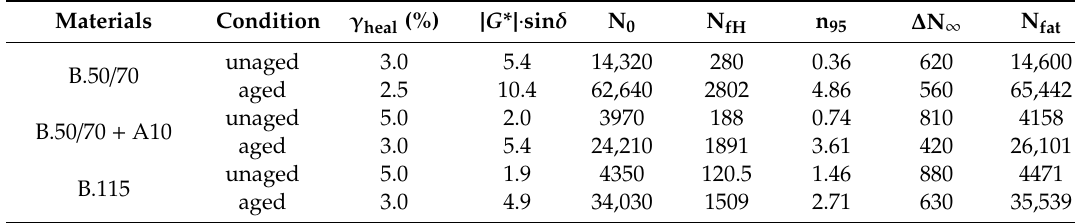
Table 6. Healing parameters in iso-thermal conditions (T = 25 °C).